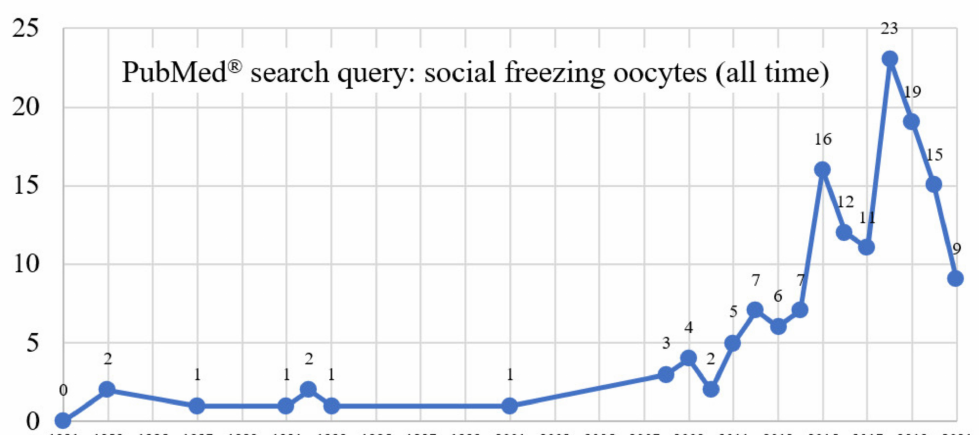
Figure 2. A systematic search for the keywords “social freezing (oocytes)” on the PubMed ® database (all-time topic) retrieved 124 results (30 reviews and meta-analysis), filtered to 54 papers refined to Medline and 25 refined to “human” since the first clinical report in 1983 [12], one systematic review [13], with three papers published during the last